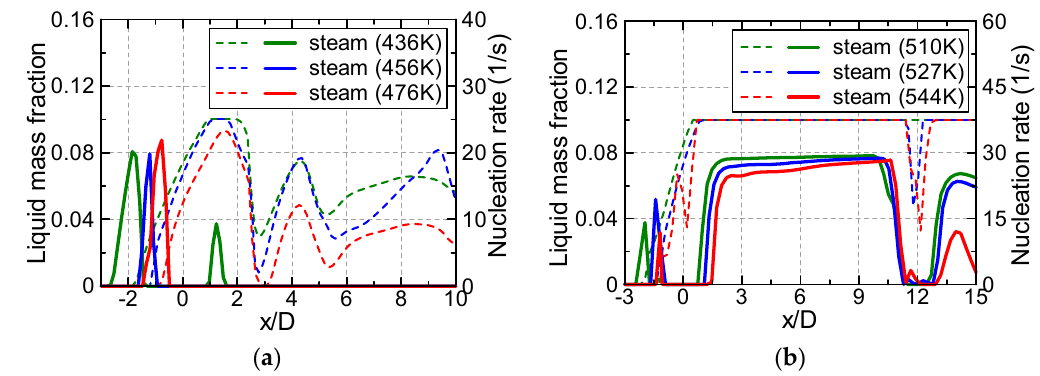
Figure 11. Distributions of liquid mass fraction and nucleation rate in wet steam flow. ( a ) p 0 = 7 bar; and ( b ) p 0 = 32 bar.